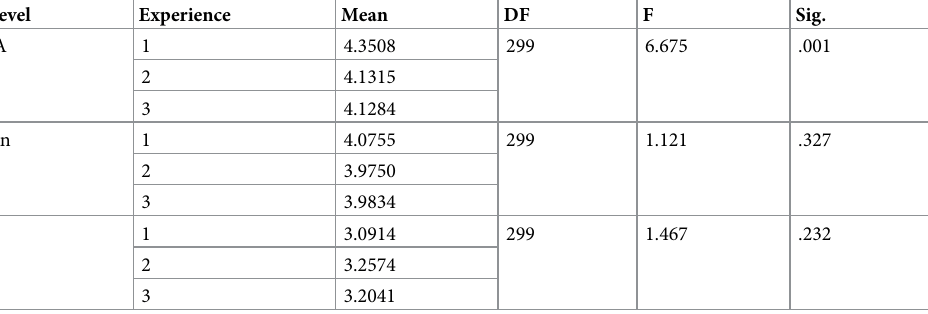
Table 6. Effect of experience on math teachers reflective